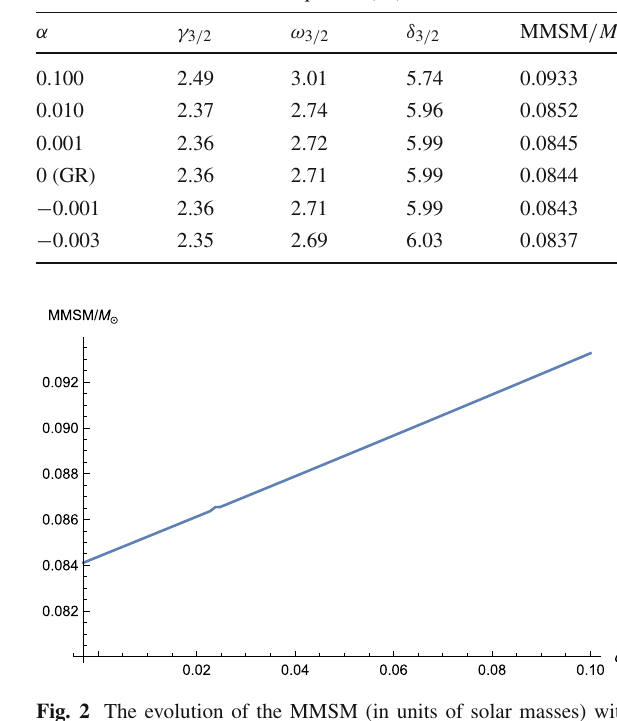
Table 1 The MMSM (in units of solar masses) computed with Eq. (64) for several values of the parameter α defined in (18), including the inter- mediate values of the parameters { γ,ω,δ } obtained from the resolution of the extended Lane–Emden equation (17)